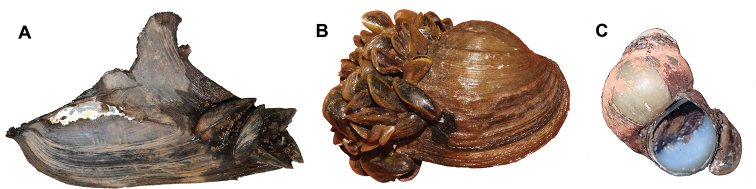
Mytilid colonies from Tonle Sap Lake, Cambodia growing on the shells of other freshwater molluscs AHyriopsis
bialataBContradens
contradensCMekongia
rattei. Photographs by A Pholyotha (A, B) and TH Ng (C).